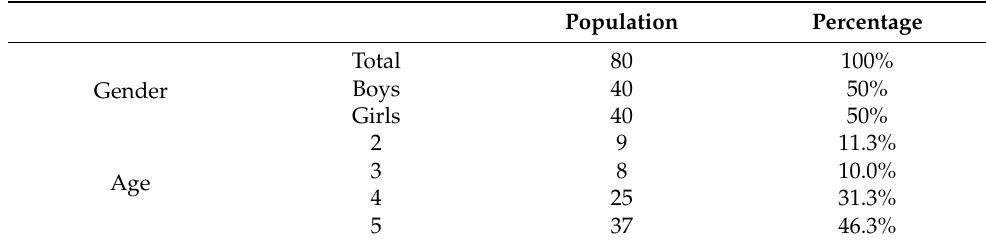
Table 1. Demographic distribution (age and gender).